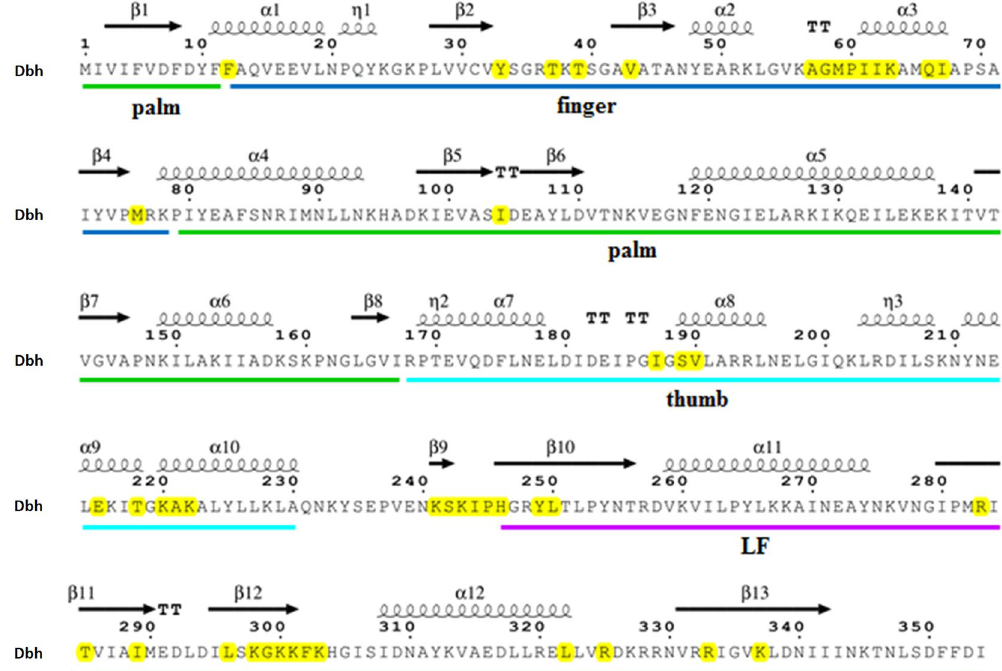
Figure 3. Non-conserved amino acids likely to interact with the DNA substrate. The Dbh amino acid sequence is shown with the domains indicated by color: palm (green), finger (blue), thumb (cyan), and LF (magenta). Non-conserved amino acids key to the interaction of Dbh and DNA duplex are highlighted in yellow. The secondary structures are indicated as coils ( α -helices) and arrows ( β -sheets) above the aligned primary amino acid